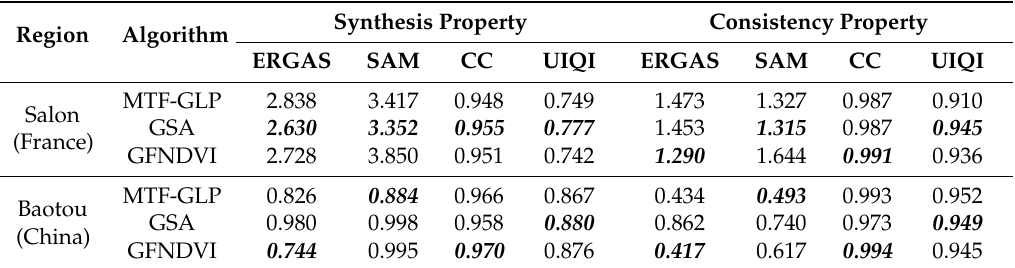
Table 3. Comparative pansharpening results corresponding to each region. ERGAS: erreur relative globale adimensionnelle de synth è se; SAM: the spectral angle mapper; CC: spatial correlation